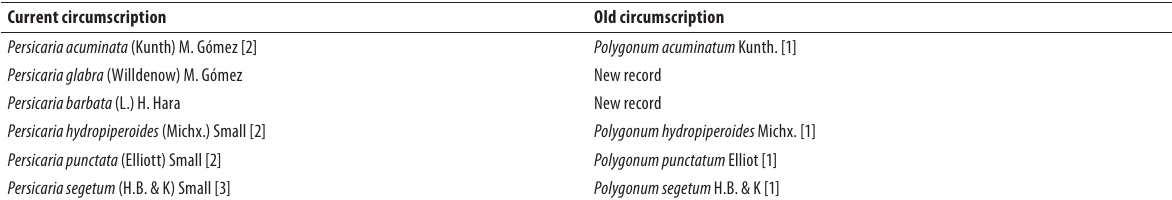
Table 1. Comparison of the current and old circumscription of the Persicaria species of the Yucatan Peninsula after the taxonomic treat- ment of Ortiz-Díaz (1994). Numbers in brackets = references: 1 = Ortiz-Diaz 1994; 2 = Carnevali et al. 2010; 3 = present